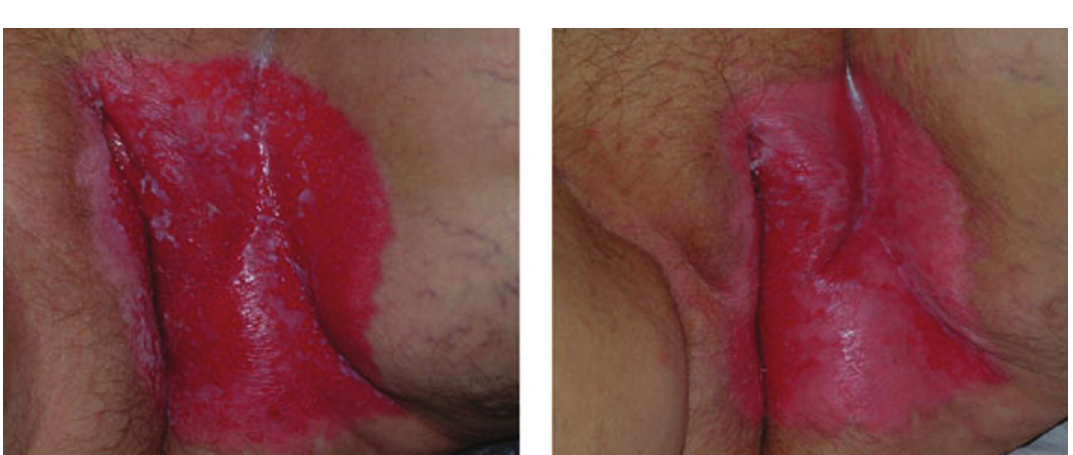
Figure 4 - Before and after treatment with PDT